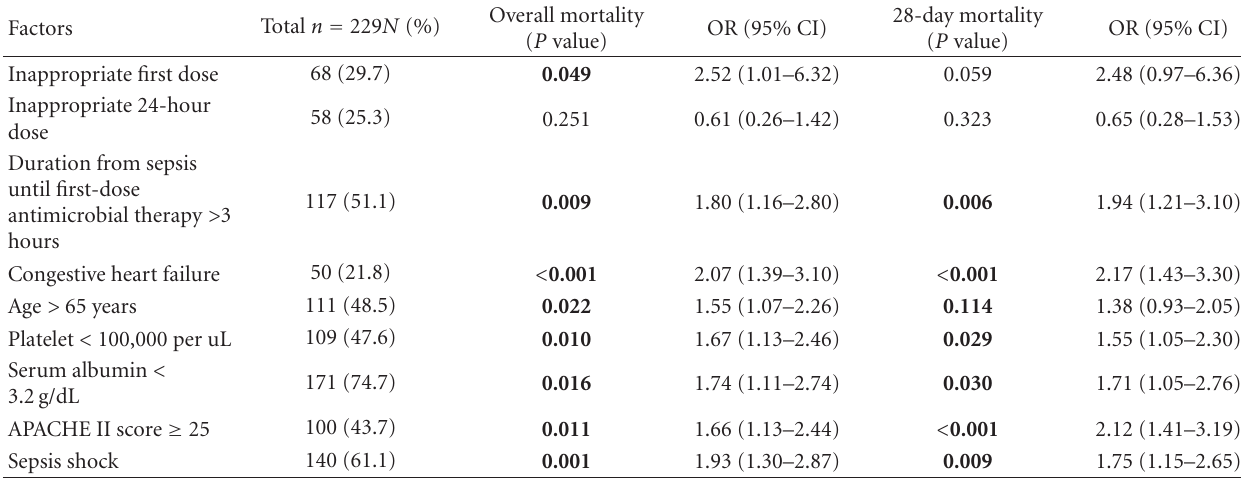
Table 7: Multivariate analysis of factors associated with 28-day and overall